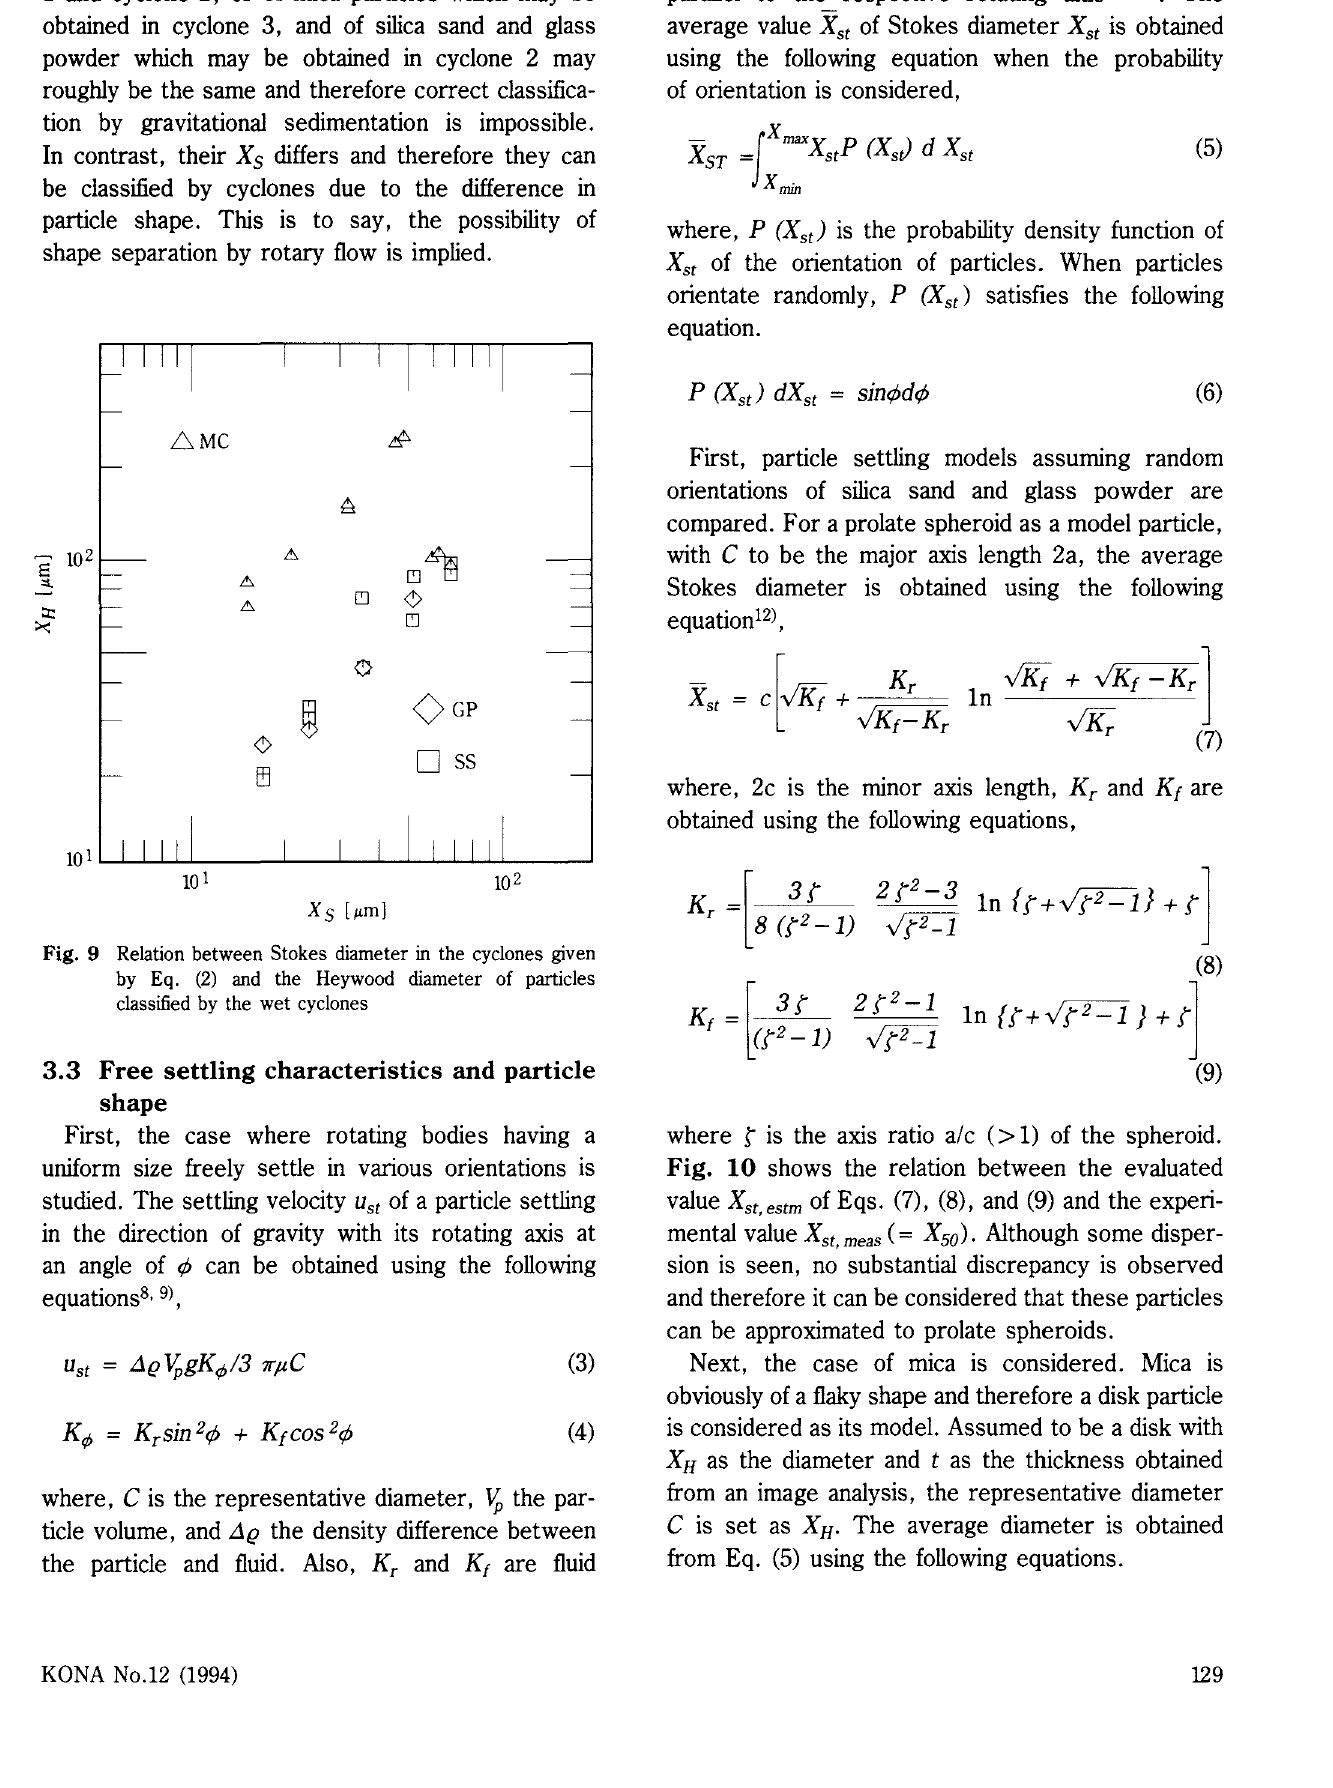
Fig. 9 Relation between Stokes diameter in the cyclones given by Eq. (2) and the Heywood diameter of particles classified by the wet